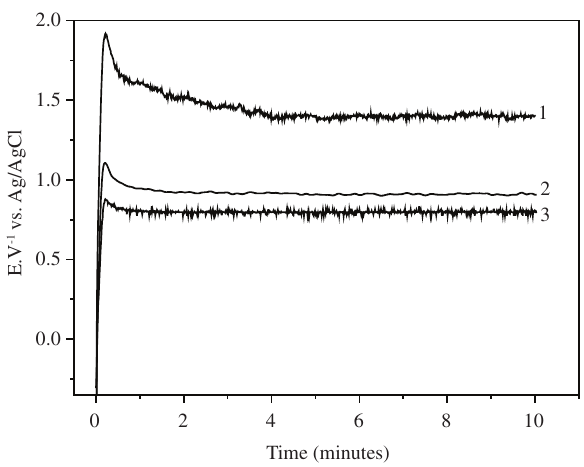
Wavenumber (cm -1 Figure 3. FTIR spectra of PPy films electrodeposited from aqueous solutions containing 0.5 mol.L -1 pyrrole + 0.2 mol L -1 of each electrolyte: a) tartaric acid; b) oxalic acid; and c) citric